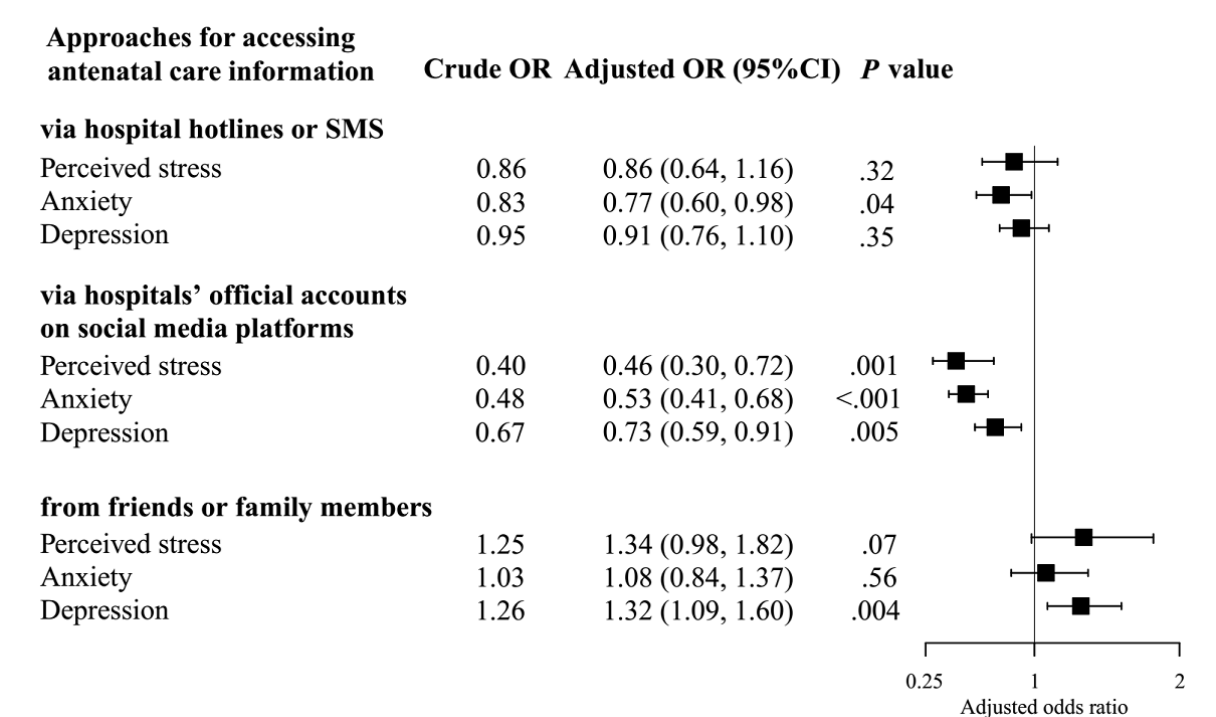
Figure 2. Approaches used by Chinese pregnant women to access antenatal care information and mental health disorders experienced by them during the COVID-19 epidemic (N=1873). Multiple binary logistic regression analysis controlled for age, education level, employment status, living area, current residence, gestational stage (trimester), parity, pregnancy complications, and scores of COVID-19 self-protection behaviors and antenatal care knowledge. OR: odds